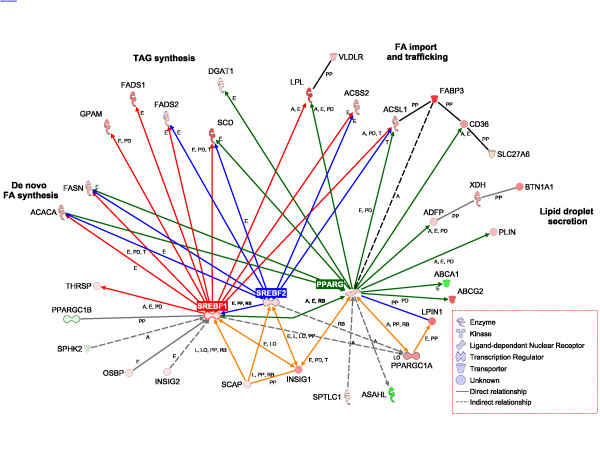
Networks among genes involved in milk fat synthesis. Networks were developed with Ingenuity Pathway Analysis® (Ingenuity Systems, ) and edited to incorporate results from the present and previous studies in bovine mammary tissue. Red nodes denote positive fold changes and green nodes negative fold changes in expression at 60 relative to -15 d. Red, blue, and green edges denote genes whose transcription is under the control of SREBF1, SREBF2, and PPARG, respectively. Highlighted in orange is the network encompassing PPARG, PPARGC1A, LPIN1, INSIG1, and SCAP which controls expression/function of SREBF proteins. Letters along the edges denote effects on activity (A), expression (E), localization (LO), proteolysis (L), RNA binding (RB), protein-DNA binding (PD), and protein-protein binding (PP). Genes are grouped based on their primary function during milk fat synthesis.